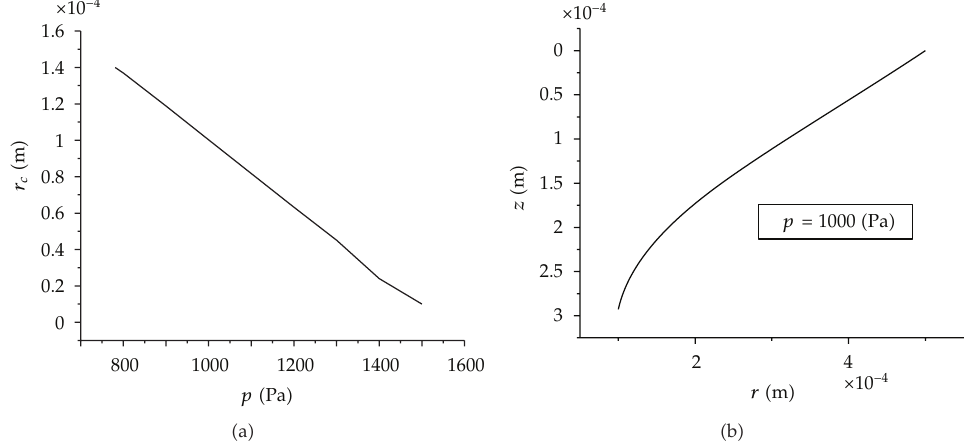
(cid:8) 0 . 523rad. (cid:6) b (cid:7) The convex-concave meridian curve for p (cid:8) c